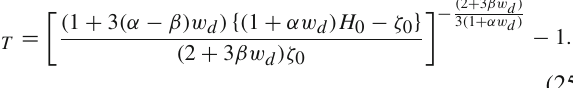
{ 1 + 3 (α − β)w } H d 0 3